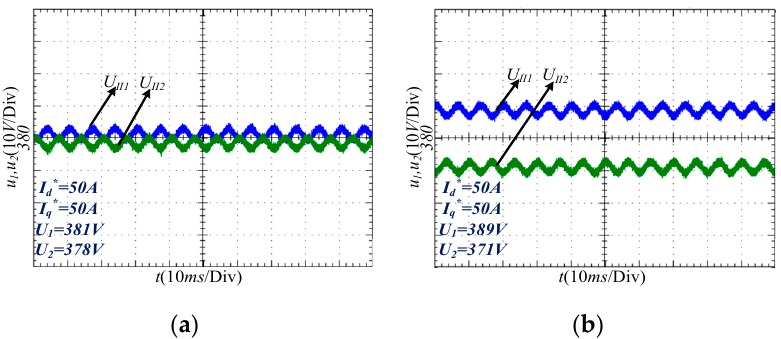
Figure 17. Waveforms of U 1 and U 2 with an external resistor. ( a ) Connected from P 2 to O 2 . ( b ) Connected from N 2 to O 2 .